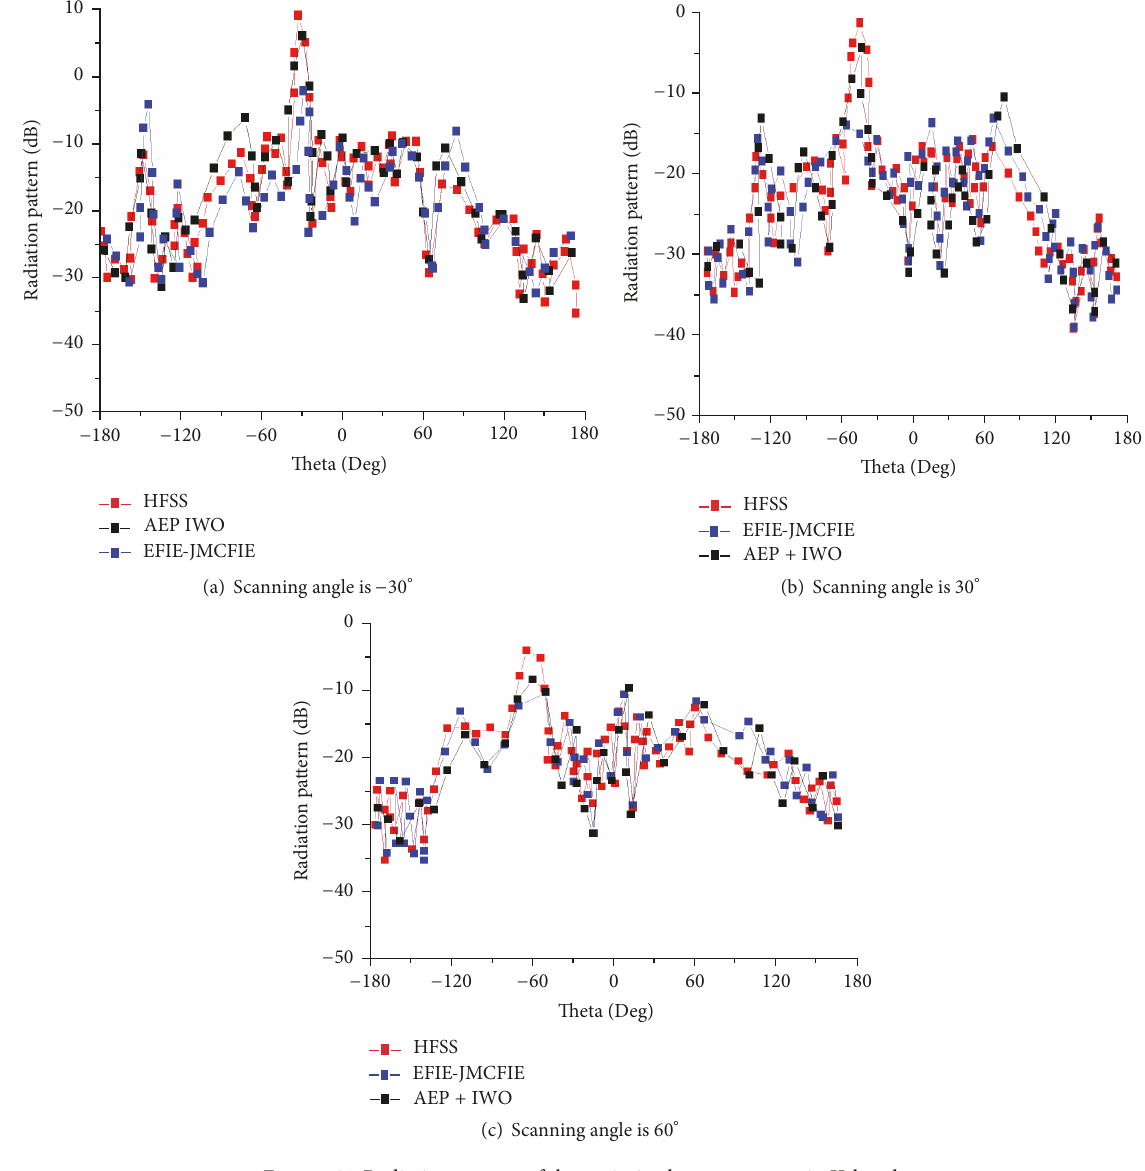
Figure 21: Radiation pattern of the optimized array antenna in K-band.